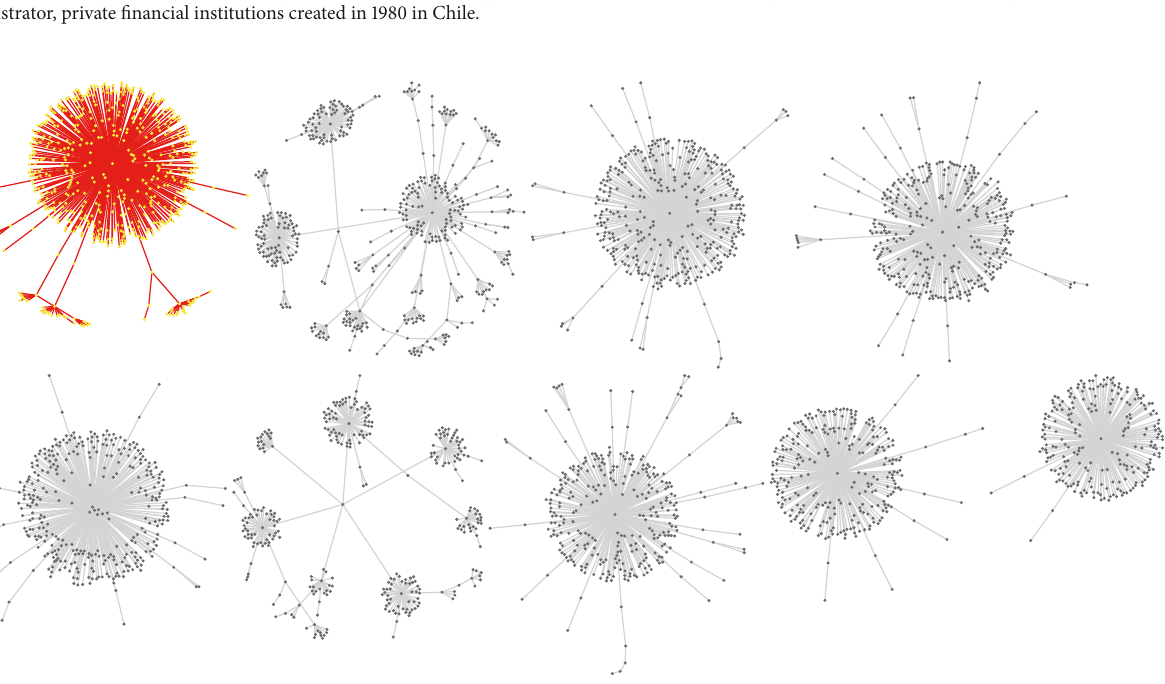
Figure 1: Partial representation of 𝐺(15198, 13466) corresponding to Case 3. Each node is a user connected to another user(s). One component is highlighted in color. The network was constructed analyzing the database provided by Analitic S.A., identifying the user who released the tweet, and processing the text of that tweet to identify other users mentioned in the message. The layout was obtained using the force-directed